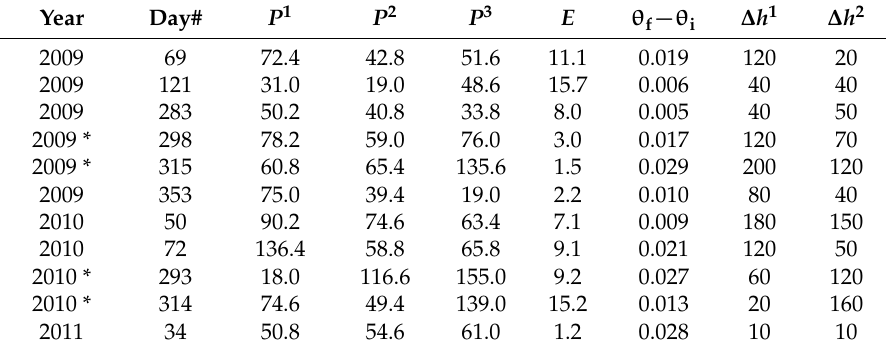
Table 1. Synopsis of the data used for the estimation of S y : final day of the event day#, precipitation P , evapotranspiration E , piezometric level change ∆ h ; superscript 1 and 2 refer to well LE-PS17 and well BR-NM2, respectively, 3 refers to the CNR-ISAC base, * indicates that consecutive events have been aggregated; all quantities in mm except ( θ f − θ I ) (volumetric depth-averaged moisture content difference, non-dimensional). Year